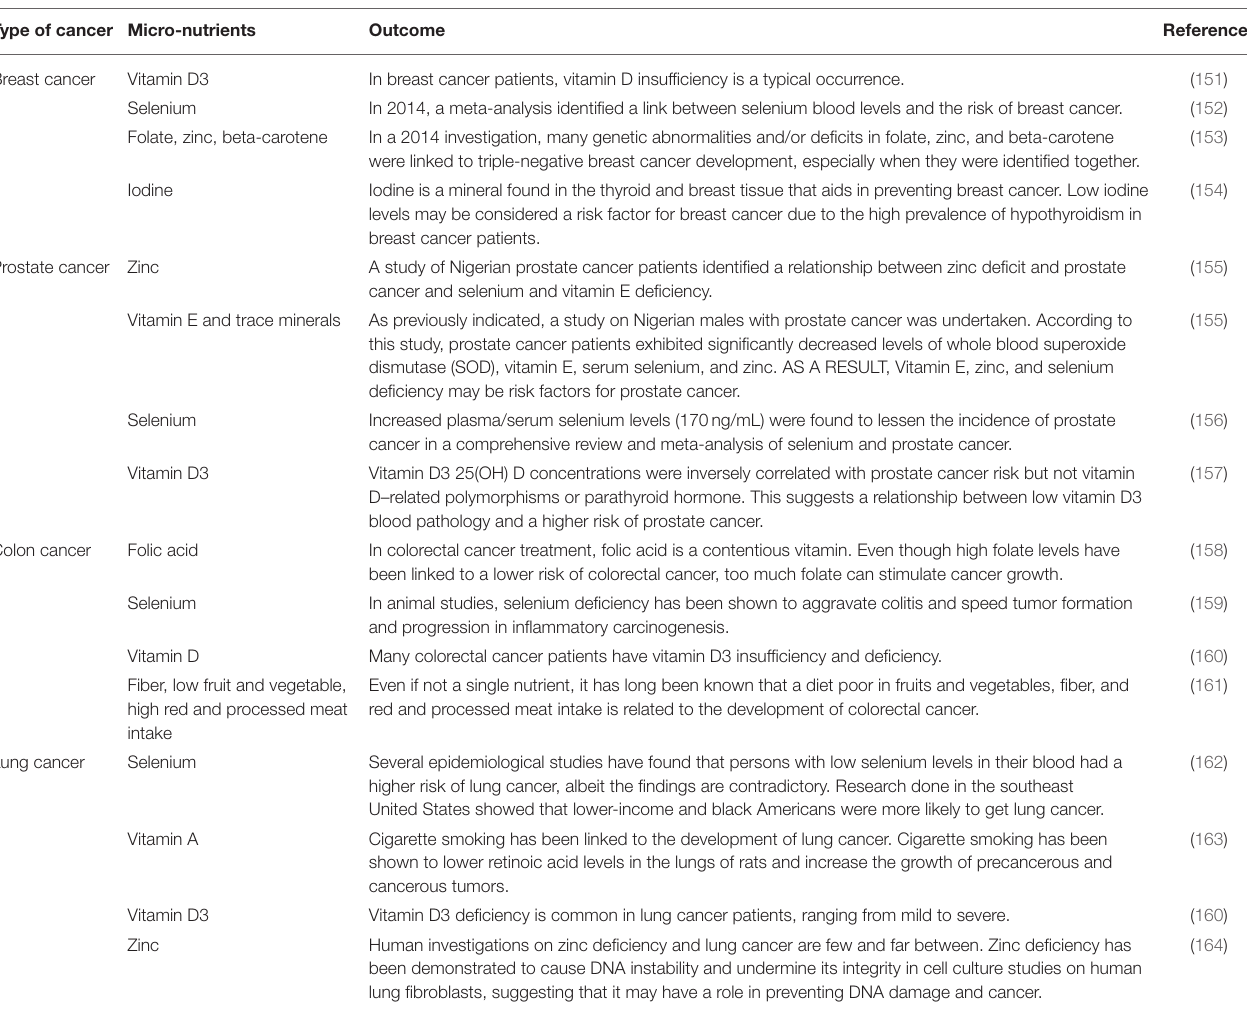
TABLE 4 | Micro-nutrient deficits linked with a variety of